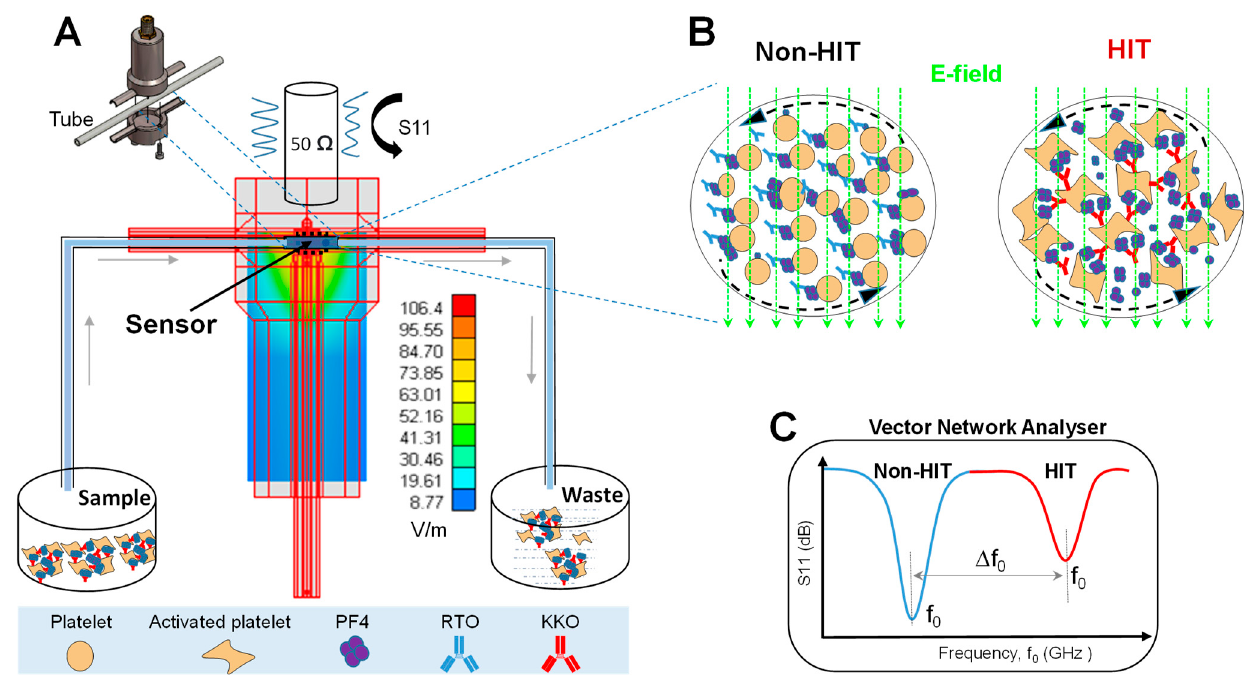
Figure 1. Schematic describes the setup of the contactless microwave sensor for the detection of HIT. ( A ) Simulation of electric field distribution (green/yellow) shows the maximal electromagnetic field at the site of the sample tube (top-left, enlargement). The tube was filled with platelets by pumping the samples ( left ) through the resonator into the waste container (right). ( B ) Sample components including platelets, PF4 released from platelets, and RTO or KKO under E-field are oriented according to dipole moments. ( C ) The expected resonant frequency vs. S11 plot shows a shift of frequency ( Δ f 0 ) measured in platelet samples caused by (red) KKO (HIT) compared to (blue) RTO (non-HIT).